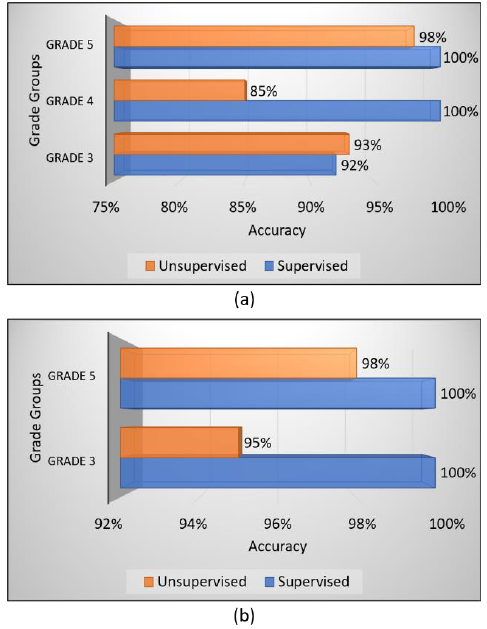
Figure 10. Bar charts of the accuracy scores of unsupervised and supervised classifications. ( a ) Multi- class classification. ( b ) Binary classification. The performance of each PCa grade was obtained from the confusion matrices.